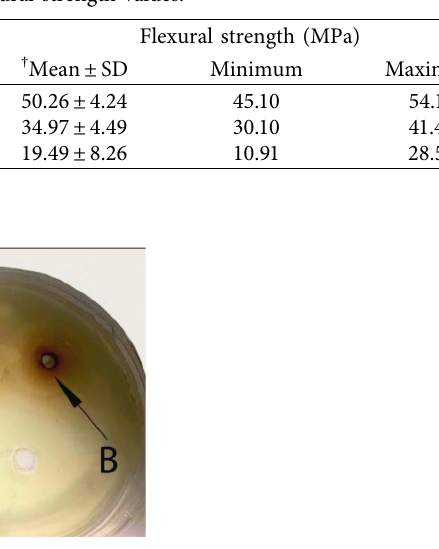
Figure 1: (a) Glass ionomer groups with (1) propolis 0%, (2) propolis 25%, and (3) propolis 50% showing no antibacterial activity against Streptococcus mutans . There was no significant difference between the groups ( p < 0.05). (b) Antibacterial activity of ciprofloxacin (A) and pure propolis (B) against Streptococcus mutans . The agar diffusion test showed an inhibition zone of 16mm for ciprofloxacin and 11 mm for pure propolis.